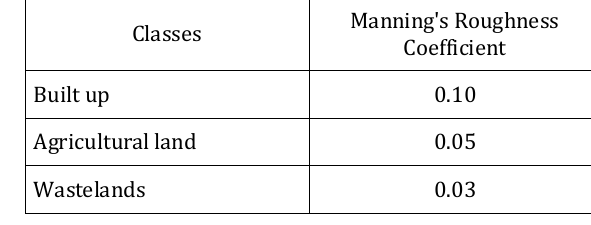
Table 2. Estimated land use and surface roughness values for